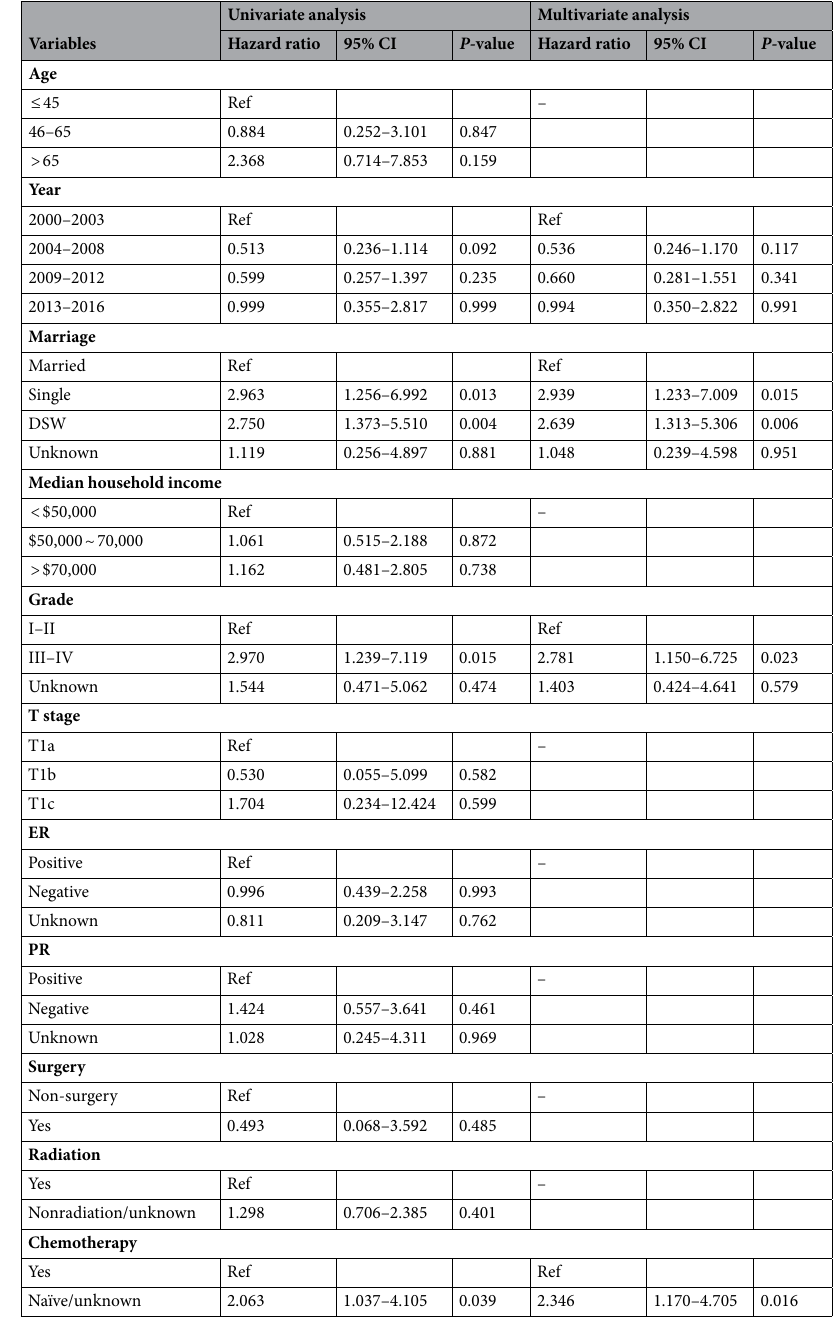
Table 4. Univariate and multivariate analysis of breast cancer-specific survival of MpBC patients. Abbreviations: CI, confidence interval; DSW, divorced/separated/widowed; ER, estrogen receptor; MpBC, metaplastic breast carcinoma; PR progesterone